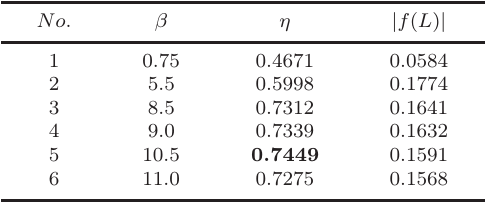
Table 2. The values of η and | f ( L ) | for ∆ = 0 . 6 , δ = 0 , I = 0 . 01 .